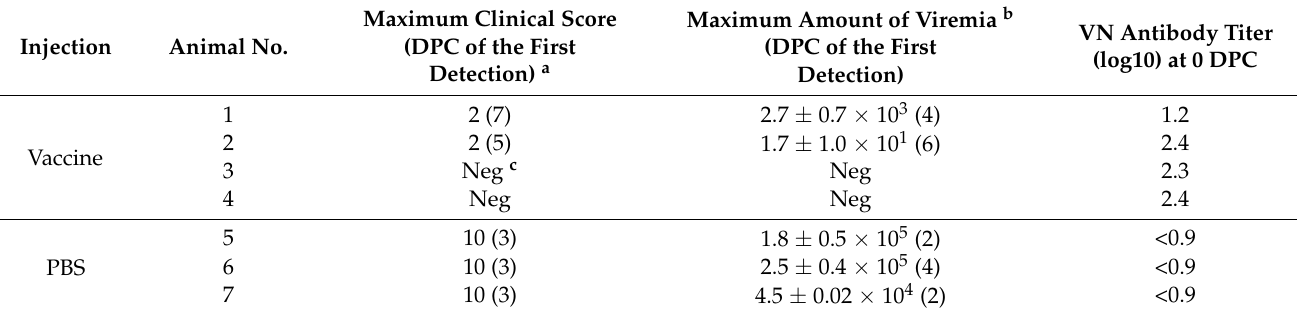
Table 2. Early protection of pigs vaccinated with the A/SKR/Yeoncheon/2017 (A-1) experimental vaccine and challenged with homologous FMDV at 7